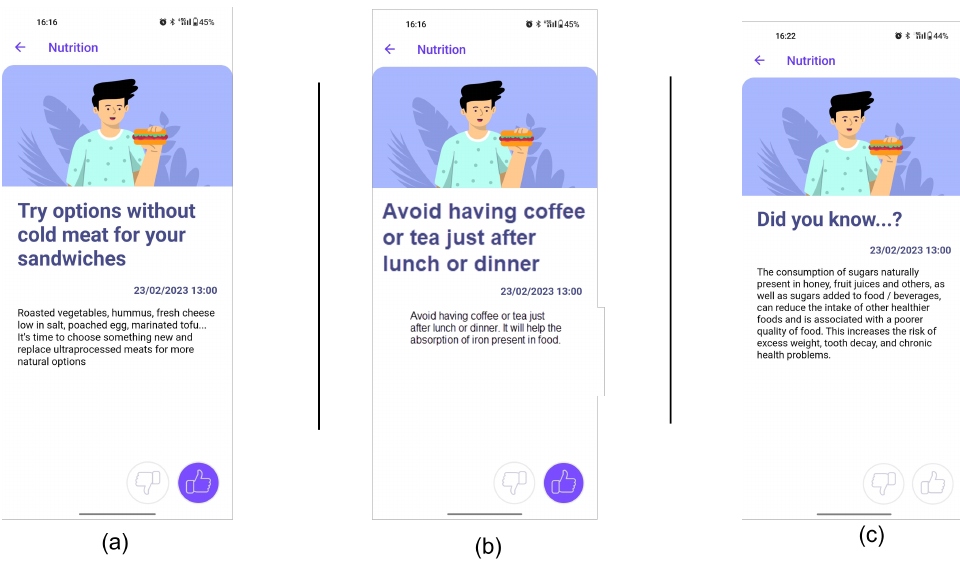
Figure 5. Screenshots from the CarpeDiem app showing different types of recommendations. ( a ) Rec- ommendation linked to mission. ( b ) General recommendation for healthy eating. ( c ) Did you know. . . ?